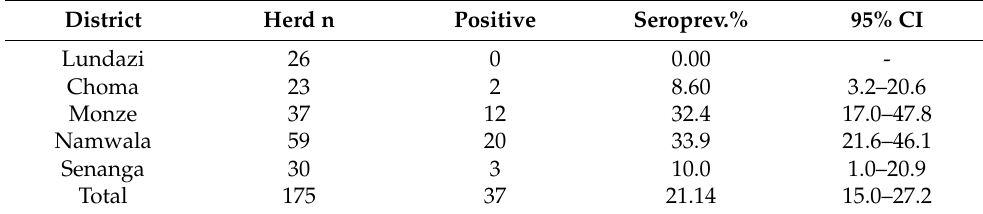
Table 2. Herd-level brucellosis seroprevalence by district.